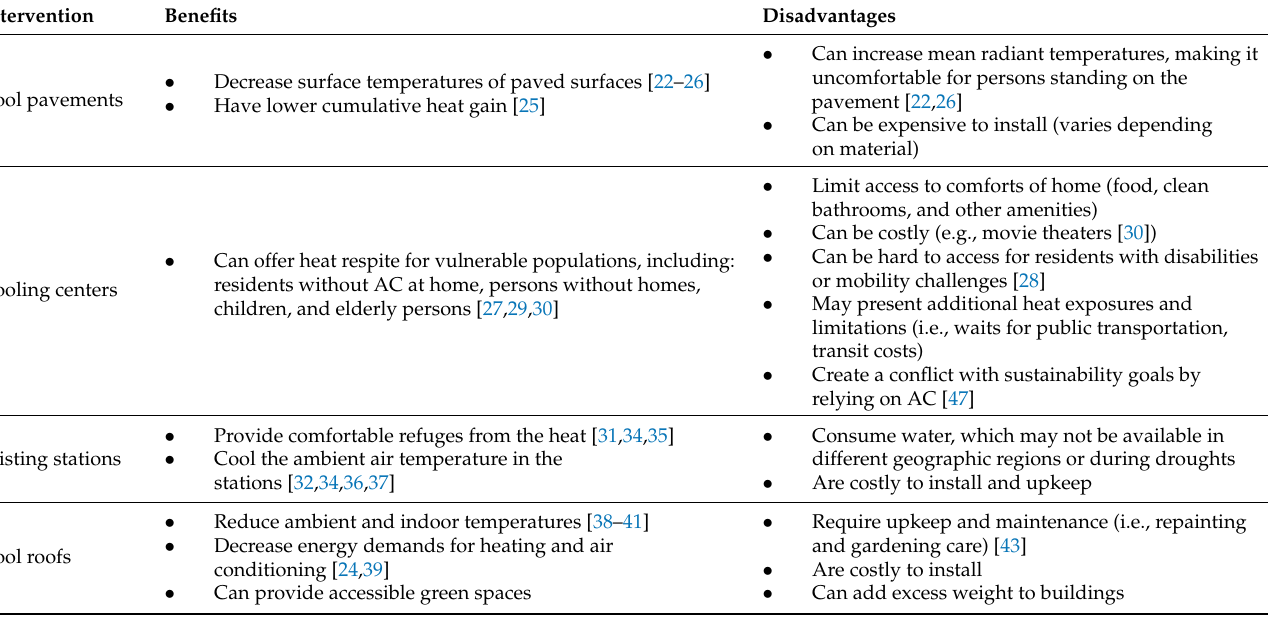
Table 6. Summary of benefits and disadvantages of each of the four cooling